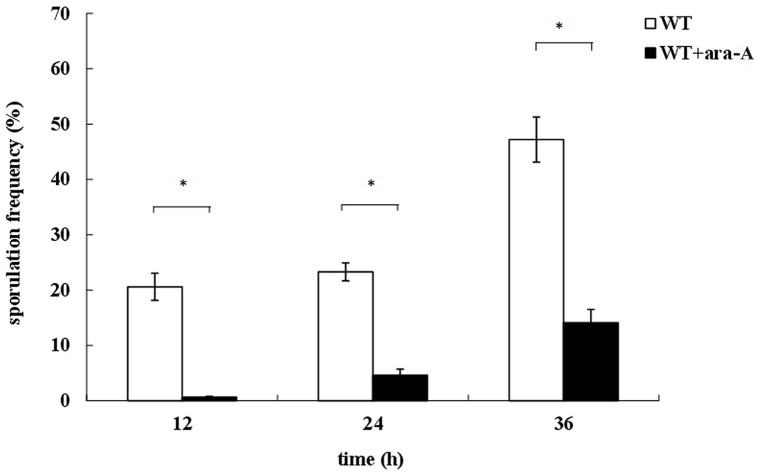
Defects of sporulation with the treatment of PrkA inhibitor ara-A. The strain Bacillus subtilis168 was cultured in 2x SG medium to induce sporulation. Sporulation frequencies of wild type (WT) strain without ara-A or with addition of ara-A were determined at 12, 24, and 36 h, respectively. The white histogram bar represents the WT strain, and the black bar represents ara-A-treatment group. ∗P < 0.01.